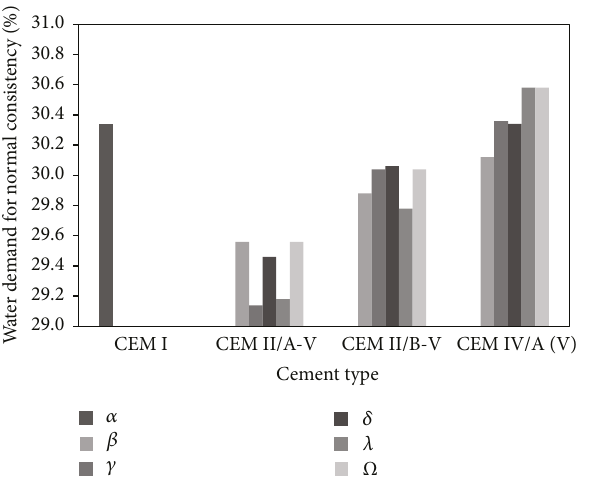
Figure 9: Soundness of the cement